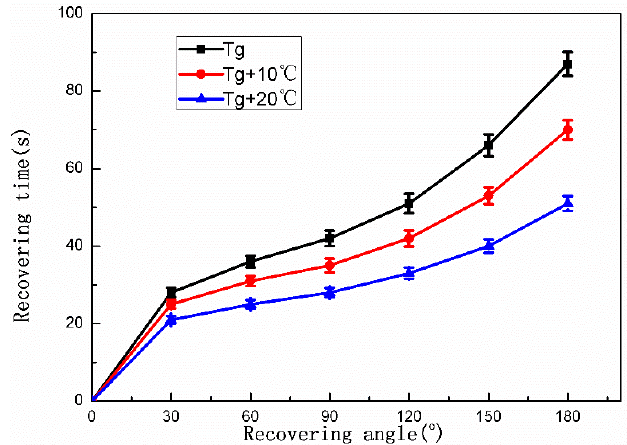
Figure 9. Relationship between recovering angle and recovering time of 12 wt % SiCw/hydro-epoxy composite at different temperatures.